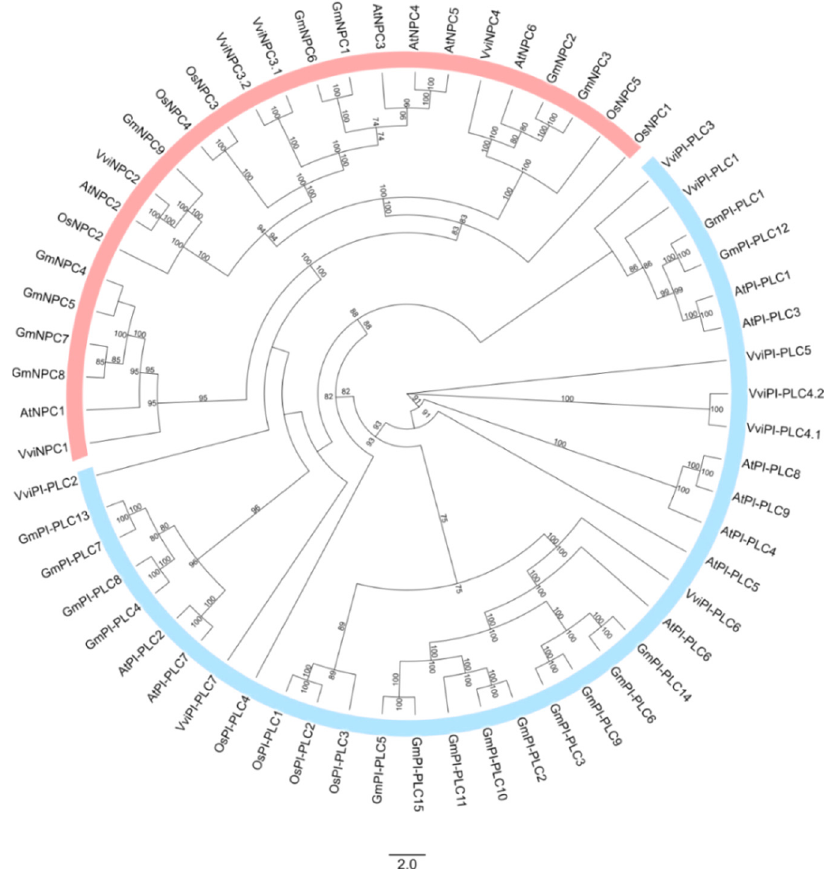
Figure 1. Maximum likelihood phylogenetic tree based on 61 Phospholipases C proteins from Arabidopsis thaliana (At), Oriza sativa (Os), Glycine max (Gm) and Vitis vinifera (Vvi). Different groups are represented by different colours: NPC in red and PI-PLC in blue. The numbers above the branches show bootstrap values. The scale bar represents the number of estimated changes per branch length.